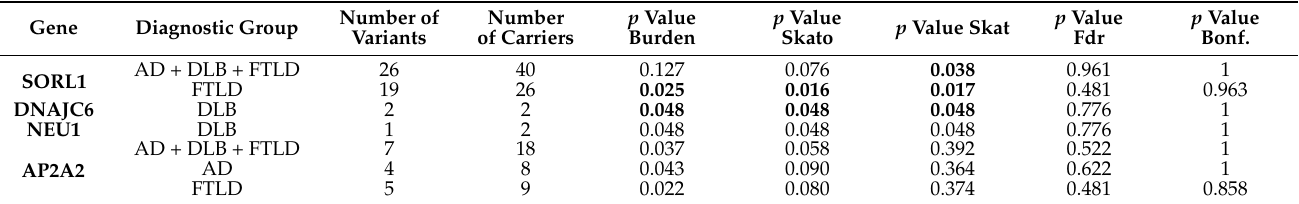
Table 6. Gene burden analysis.